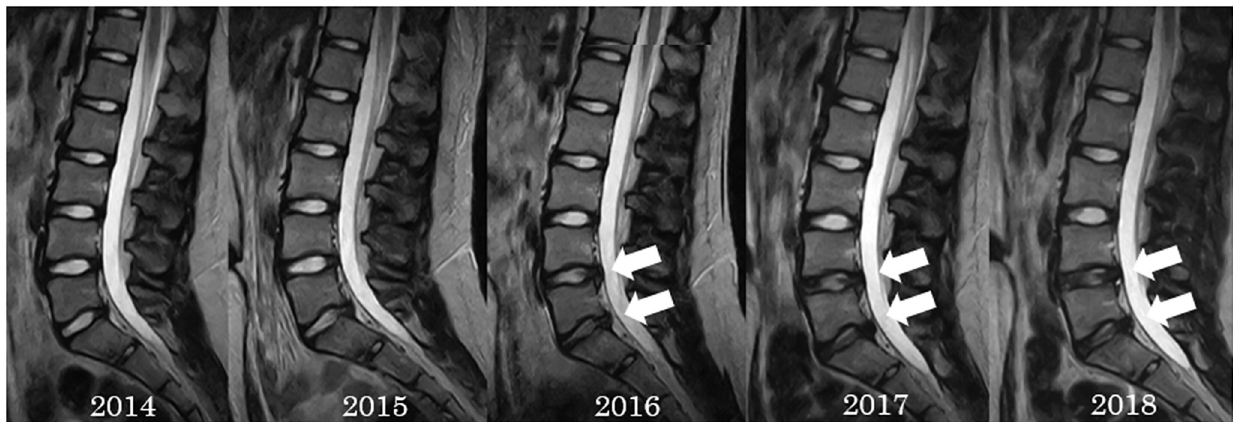
Fig 2. Representative case (patient 8). There were no findings in 2014. From 2016, there was progressive lumbar disc degeneration and disc herniation at L4/5 and